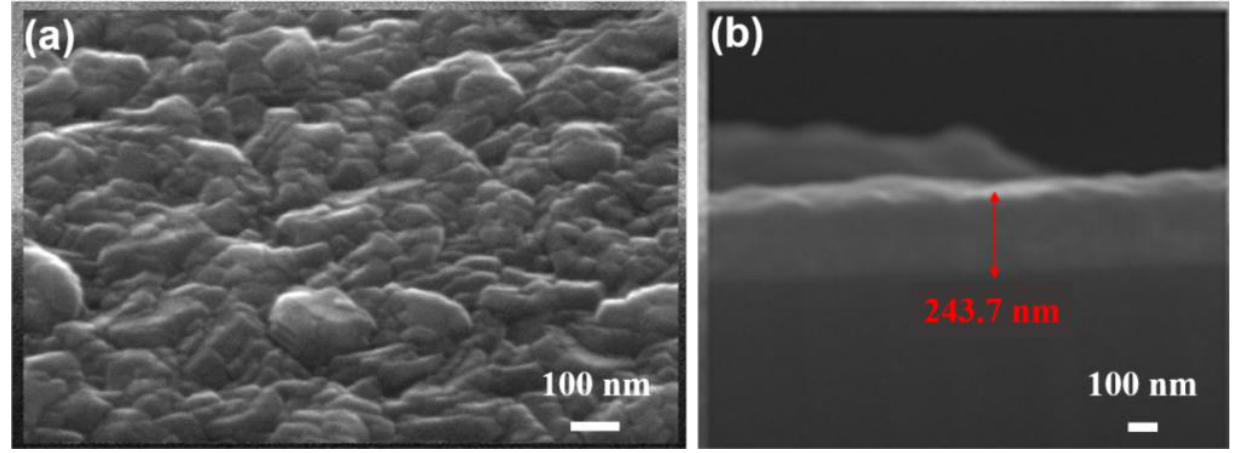
Figure 2. SEM images of ITO thin film with ( a ) top and ( b ) cross-sectional view. Further, the elemental compositions of the ITO thin film were examined using energy- dispersive spectroscopy (EDS). This is displayed in Figure 3a. The acqured spectra revealed the existance of indium (In), tin (Sn), and oxygen (O) in the e-gun deposited ITO thin film. The weight percentage of In, Sn, and O is 68.91%, 7.27%, and 23.82%, respectivly, whereas, the atomic percentage of In, Sn, and O is 27.91%, 2.85%, and 69.24%, respectivly. The surface topography of the ITO thin film was also characterized using AFM as shown in Figure 3b. The average and root mean squre (RMS) roughnesses of the thin film are 25.1 and 30.5 nm, respectivly. Such high degree of rougness of the ITO thin film can provide a wide range of opportunities for roughness-induced, plasmon-assisted absorption of exciting optical radiation at the metal/semiconductor interface [44,45]. In related work, Wu et al. [38] showed that enhanced THz emission can be observed from GaAs (100) surfaces coated with thin (3–20 nm), inhomogeneous, and rough Au